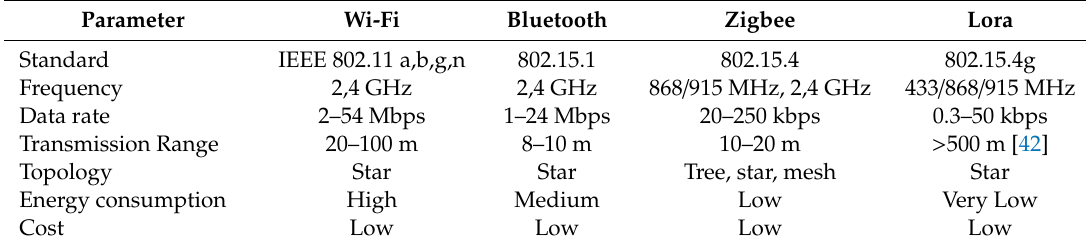
Table 1. Local network communication technology characteristics.